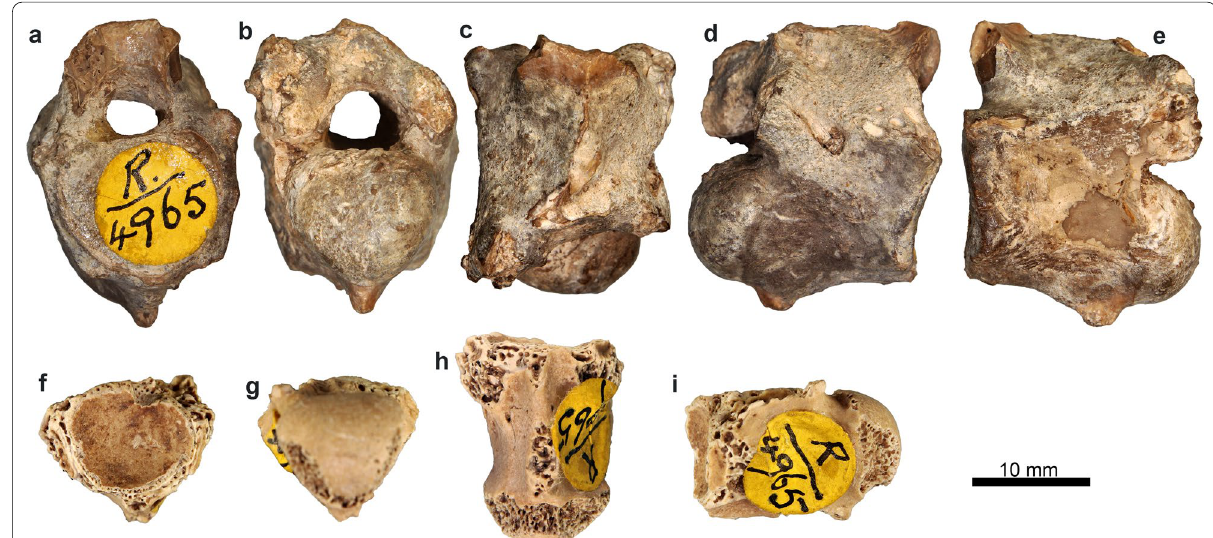
Fig. 11 Referred specimens of Palaeophis africanus from the middle Eocene of Oshosun Formation, Nigeria. a–e Trunk vertebra NHMUK PV R 4965(1) in anterior ( a ), posterior ( b ), dorsal ( c ), right lateral ( d ), and left lateral ( e ) views; f–i trunk vertebra NHMUK PV R 4965(2) in anterior ( f ), posterior ( g ), ventral ( h ), and left lateral ( i ) views. Both these specimens were originally mentioned by Andrews (1924) but had never been figured so far. From the collections of the Natural History Museum,